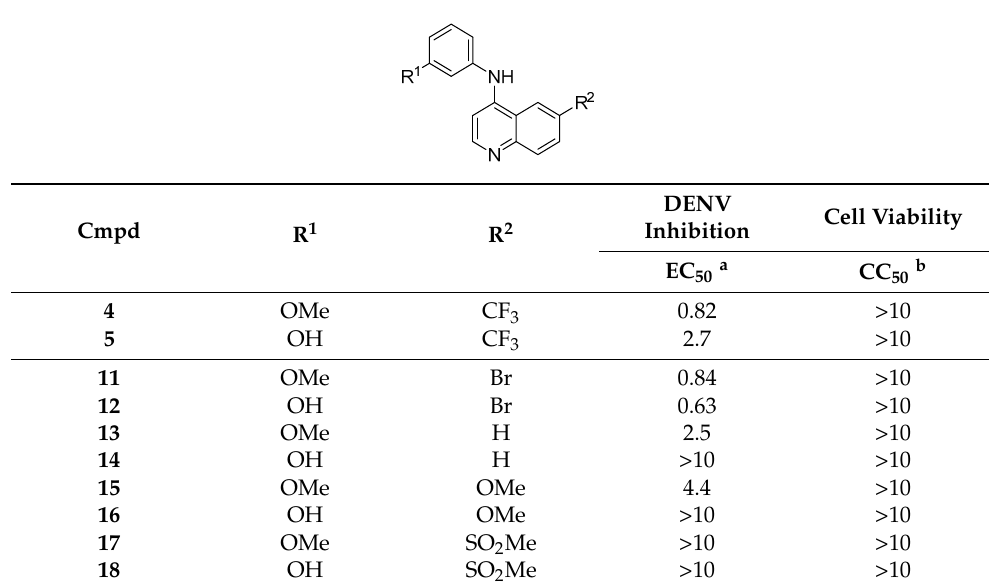
Table 2. Screening results of anti-DENV activity of matched pair methoxy and hydroxy aniline analogues.